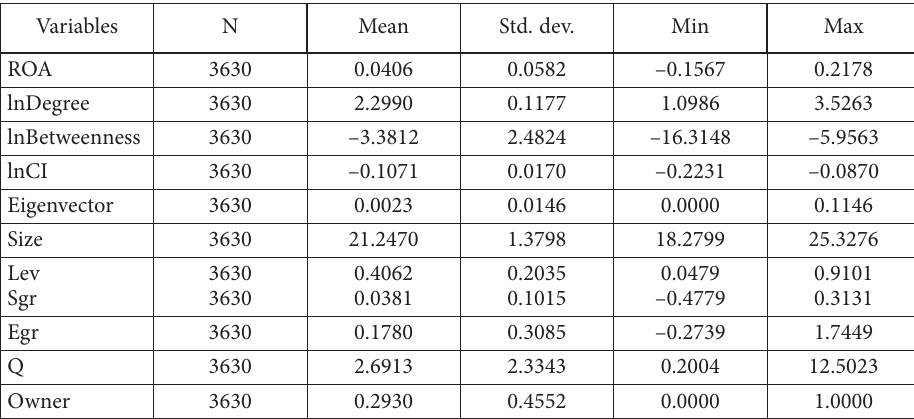
Table 1. Summary